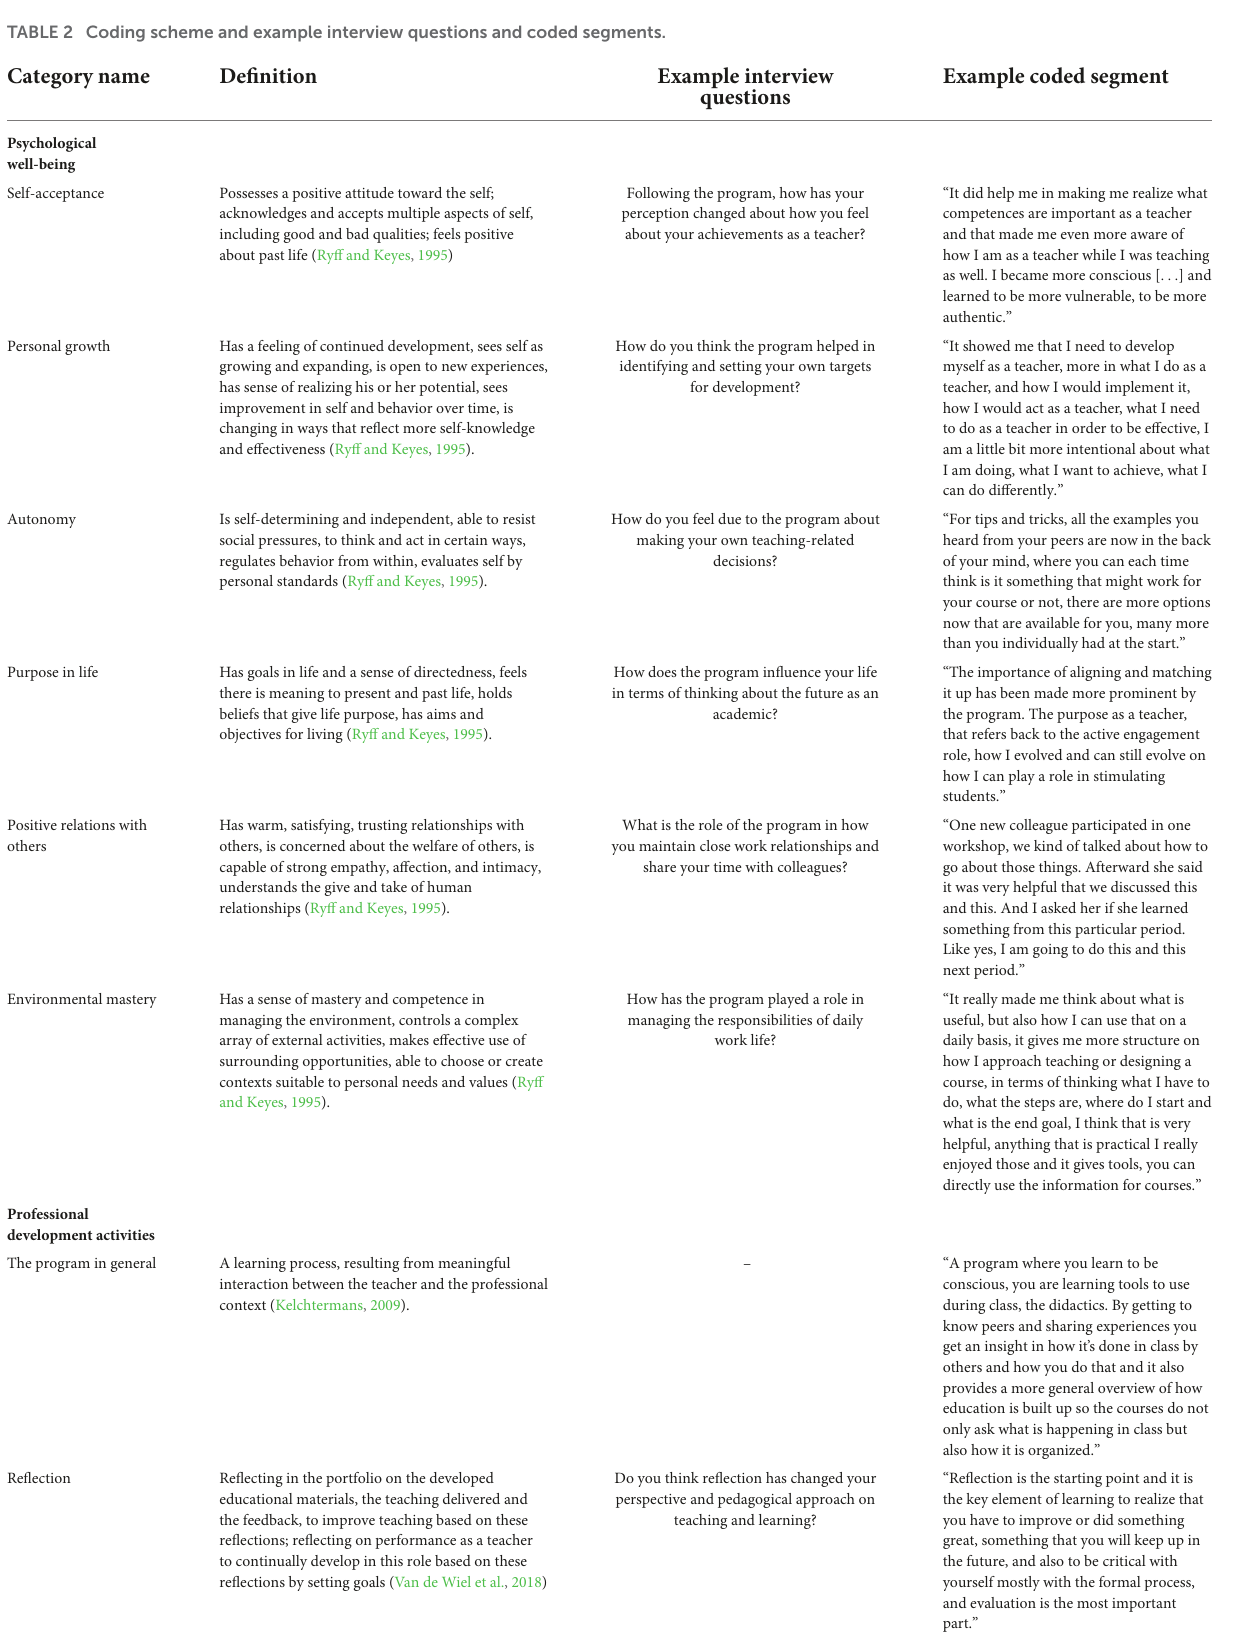
TABLE 2 Coding scheme and example interview questions and coded